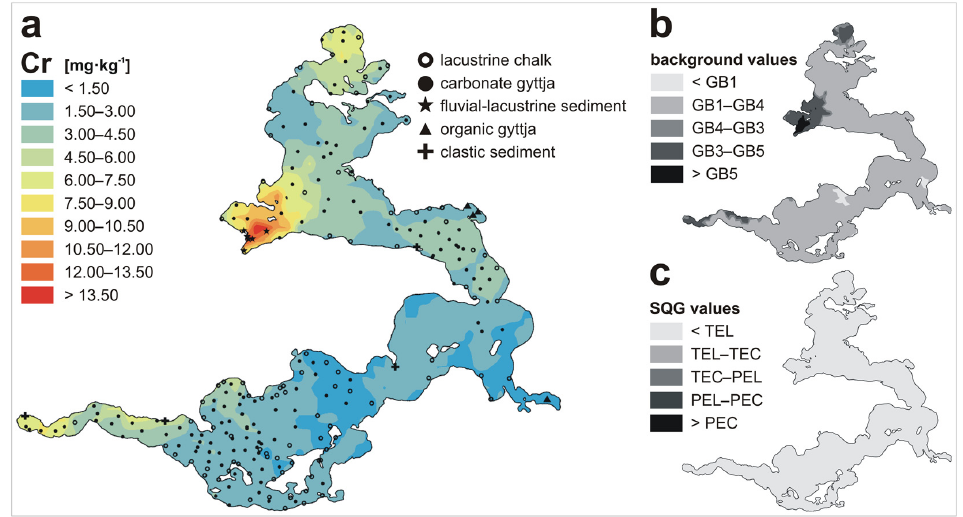
Figure 6. Chromium in recent bottom sediments of the Wigry Lake: ( a ) spatial distribution of Cr; ( b ) Cr mapped according to different geochemical background values implemented in the study (Table 3); ( c ) Cr mapped according to sediment quality guideline values (TEL—threshold effect level, TEC— threshold effect concentration, PEL—probable effect level, PEC—probable effect concentration [59,60]; Table 3).